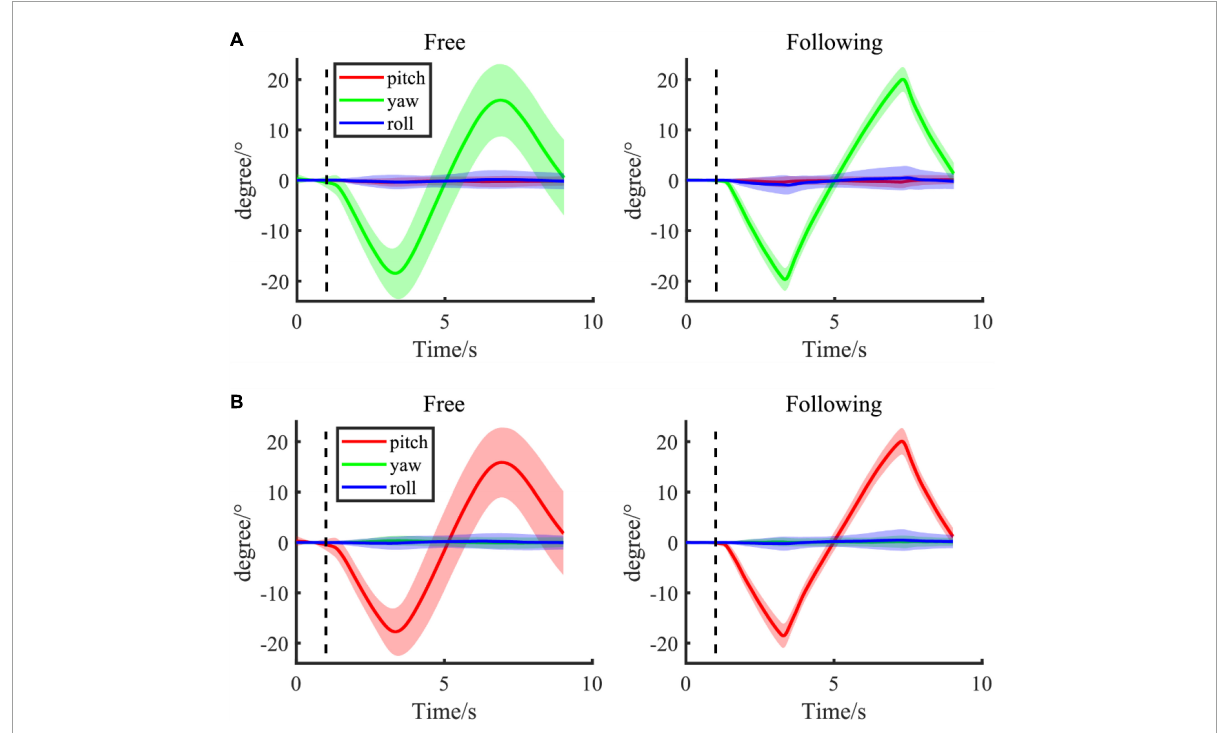
FIGURE3 (A,B) Group average of Euler angle change in different following tasks (left column: free task; right column: following task) with different moving patterns, including yaw and pitch. The shadow area presented the standard error of the group population.